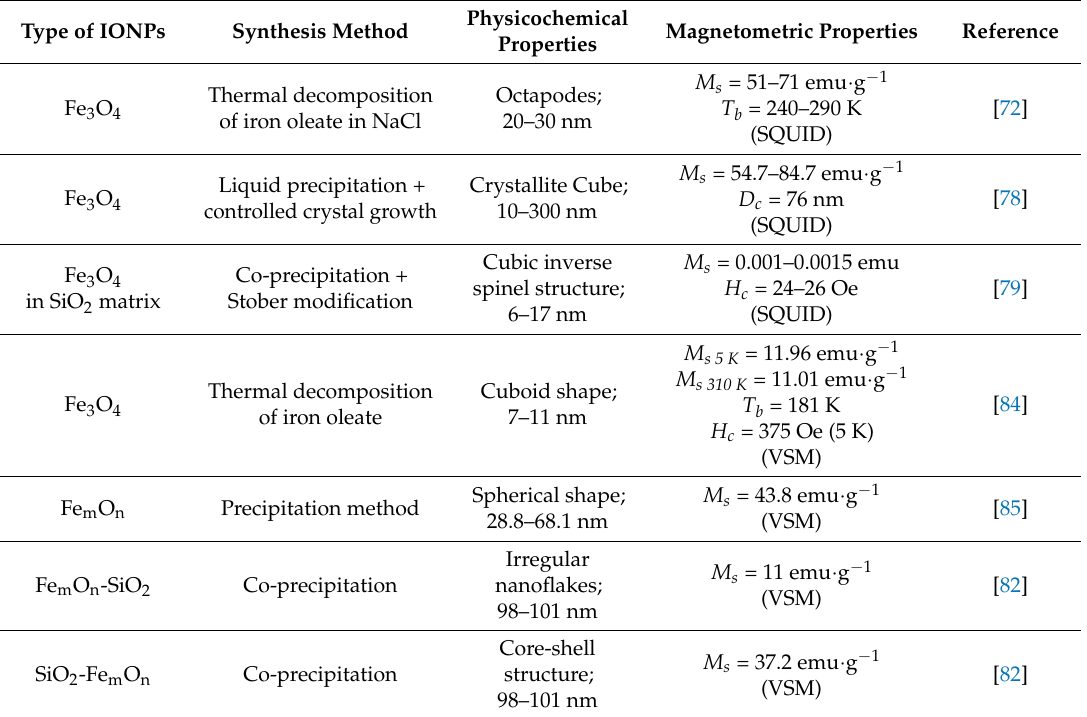
Table 3. Examples of different types of